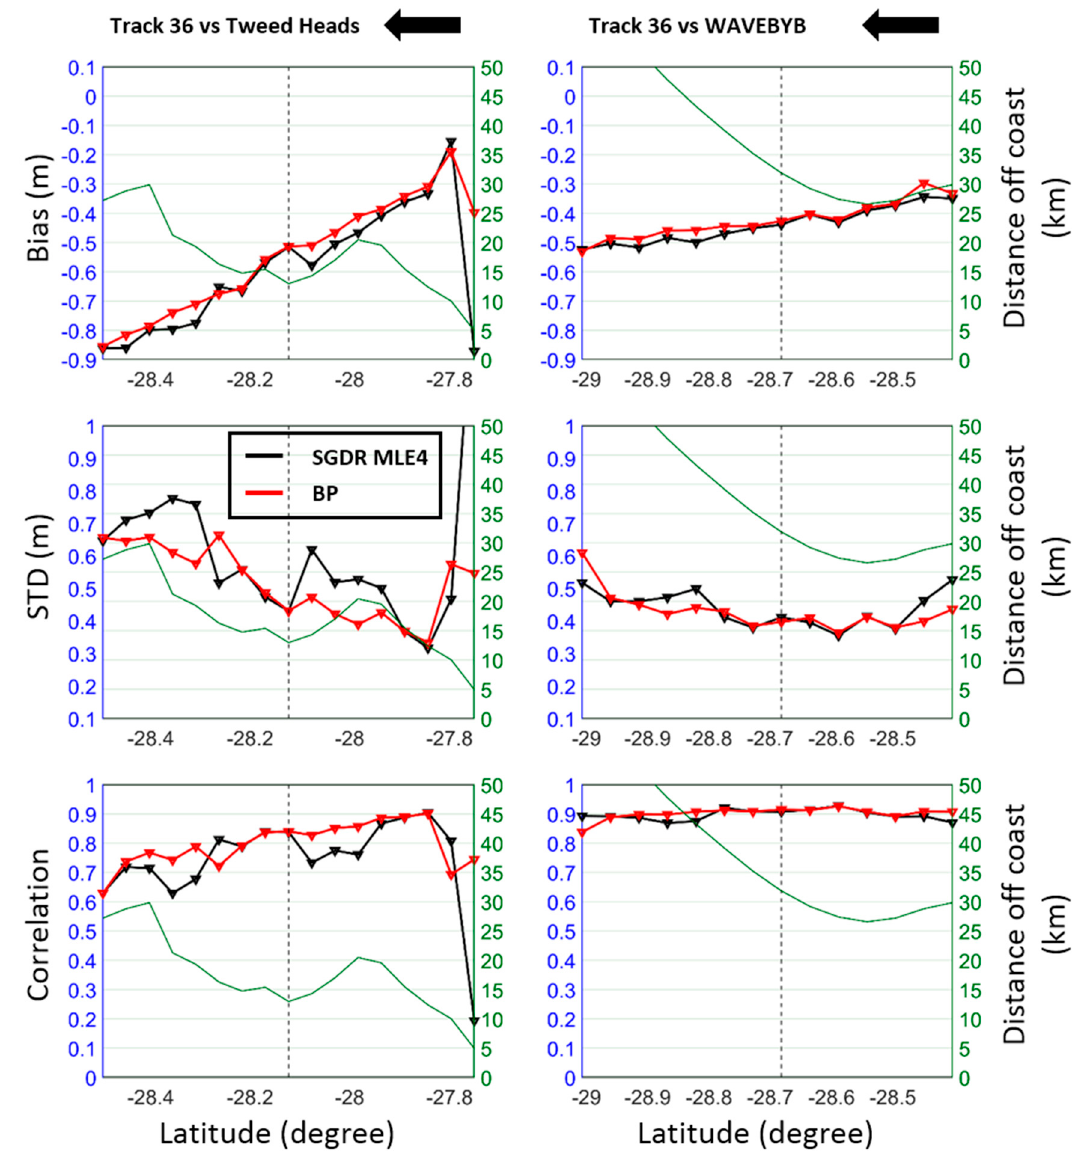
Figure 8. Similar to Figure 5, but for tracks 36 against buoy SWHs at Tweed Heads ( left ) and WAVEBYB ( right ) in South Queensland.